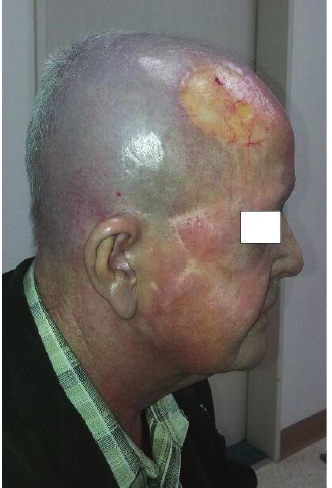
Figure 3: Four months after completing chemoradiotherapy with complete resolution of the radiation dermatitis. Note the small skin ulcer centred in the skin